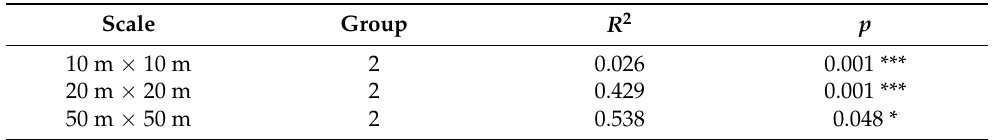
Table A1. ANOSIM statistical test parameters of plant community taxonomy at different sam- pling scales. Scale Group R